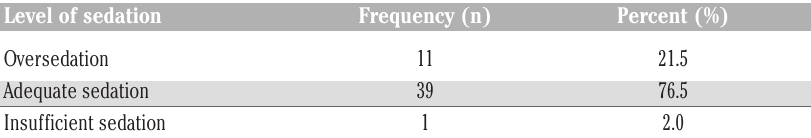
Table 2. Distribution of sedation levels using CBS (N=